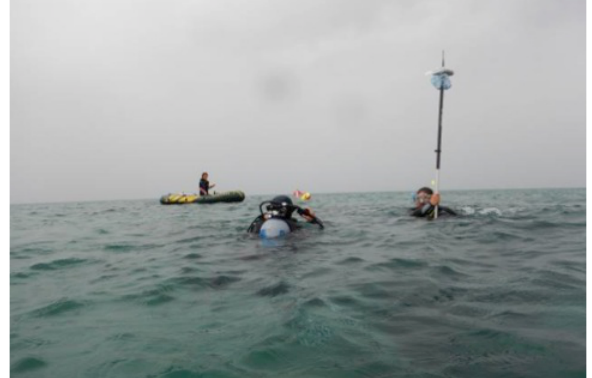
Figure 5. Marzamemi shipwreck. Trilateration of the CGP by